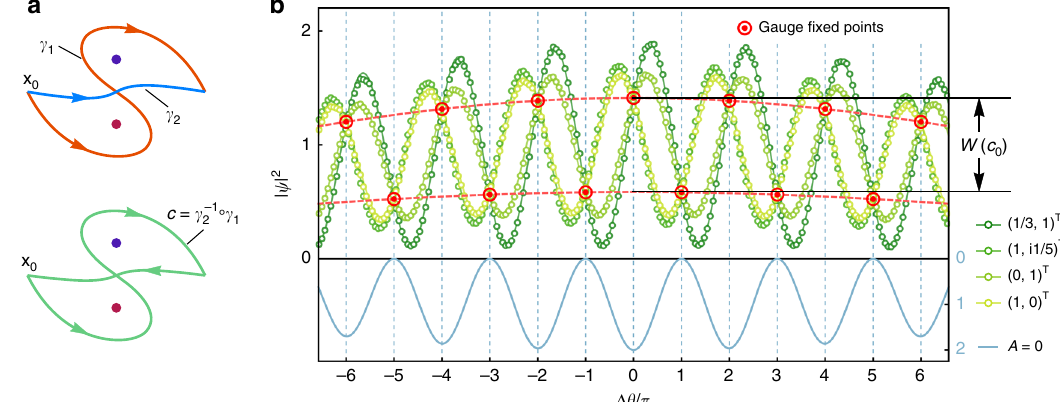
Fig. 4 Extracting Wilson loops from gauge fi xed points. a For two arbitrary beams γ 1 , γ 2 interfering on the screen, the Wilson loop of the concatenate path γ can be extracted from the interference fringes of the two beams. b Four intensity interference curves corresponding to four different incident c ¼ γ (cid:2) 1 2 (cid:9) 1 spinors ð 1 ; 0 Þ > , ð 0 ; 1 Þ > , ð 1 ; i 1 = 5 Þ > , ð 1 = 3 ; 1 Þ > for the non-Abelian AB system shown in Fig. 3a with vortex fl uxes Φ 1 ¼ 0 : 22 π , Φ 2 ¼ (cid:2) 0 : 33 π , where circles and solid curves represent numerical and analytical results, respectively. Their intersections, marked by red targets, are the gauge fi xed points, which are located at the crests and troughs of the interference fringes (light blue curve) of ^ A ¼ 0. The maximal difference between the envelops of even and odd gauge fi xed points gives the Wilson loop W ð c 0 Þ of c 0 ¼ γ (cid:2) 1 (cid:9) γ II